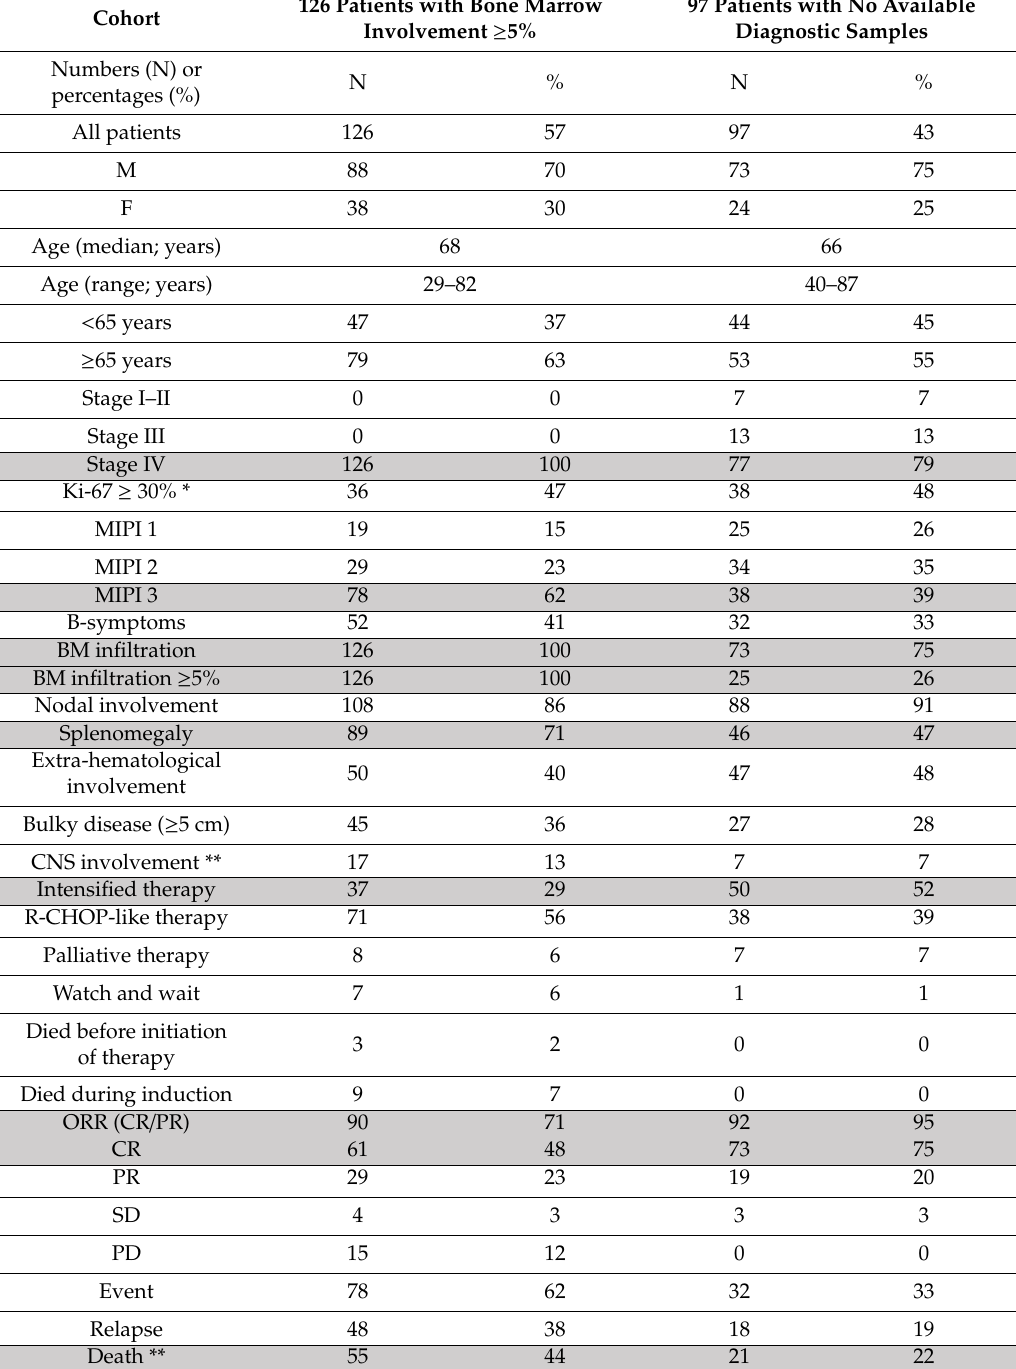
Table 1. Baseline characteristics and response to therapy of the analyzed and non-analyzed patients.